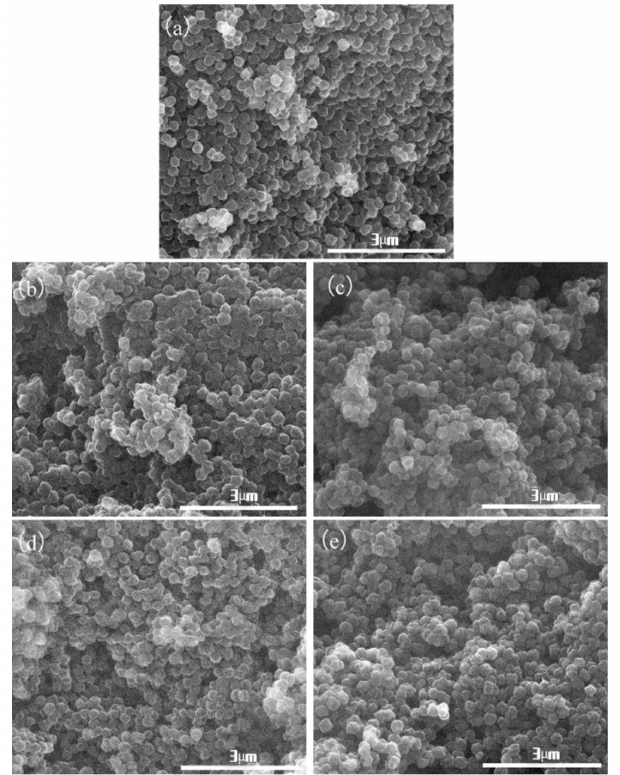
Figure 1. Material morphology of two-step activation method with different activation holding time: ( a ) CAPN; ( b ) 2APCNs-1; ( c ) 2APCNs-1.5; ( d ) 2APCNs-2; ( e )